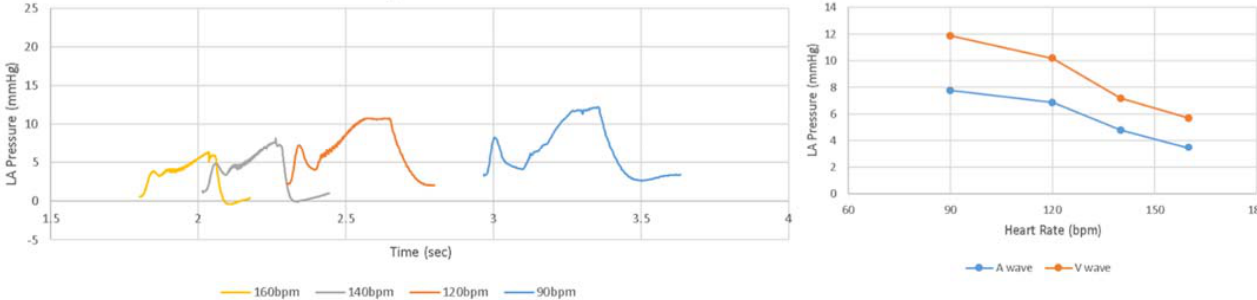
Figure 5. (Left) Pressure time traces for left atrium at the fifth cardiac cycle, as well as ( Right ) magnitudes of A wave and V wave left atrium pressures for simulations of heart rate related to pacing at 90 and 160 beats per minute.